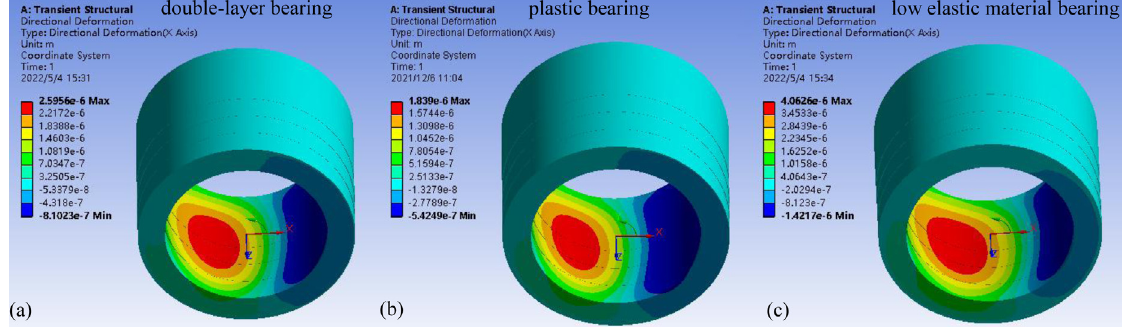
Fig. 6. Bush radial deformation contours of (a) Double-layer bearing, (b) Plastic bearing, and (c) Low elastic material